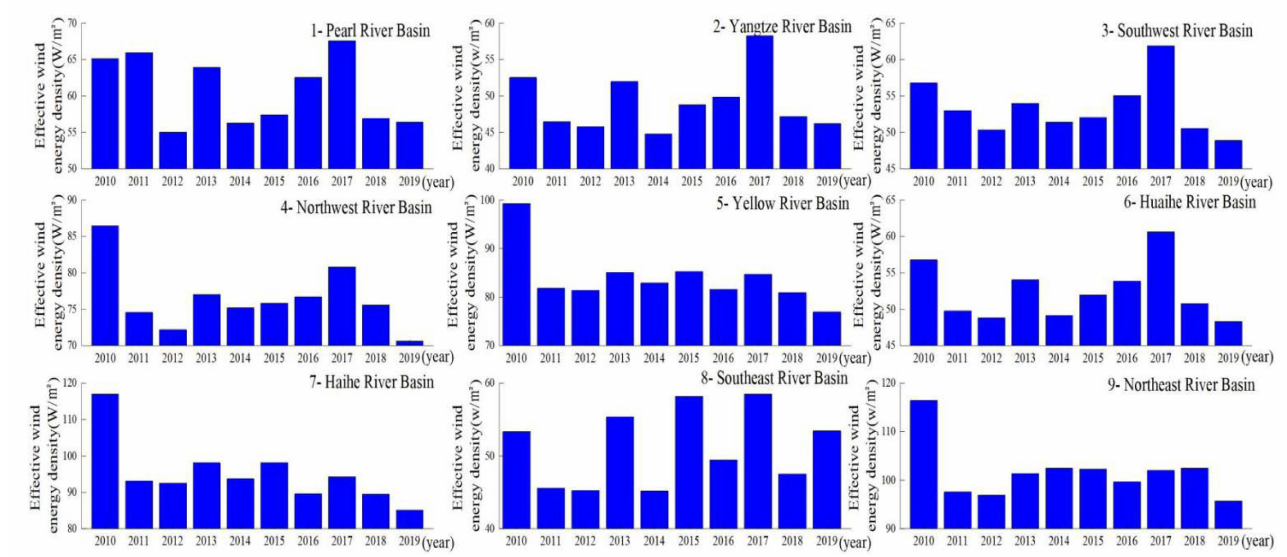
Figure 3. Interannual variation in average effective wind-energy density in nine river basins of China from 2010 to 2019.